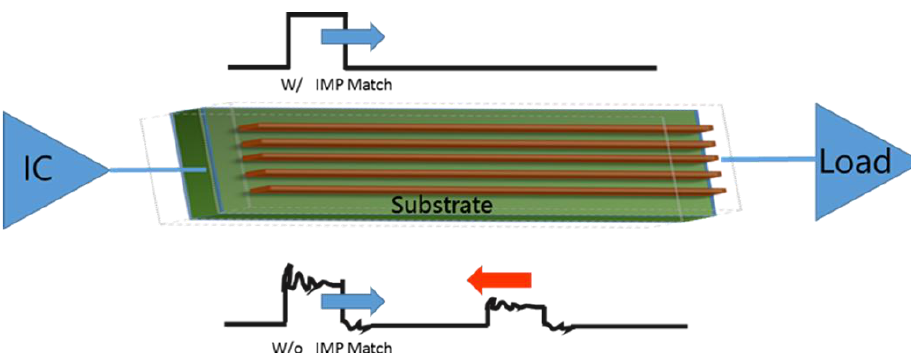
Figure 1. Circuit signal transmission on the substrate.